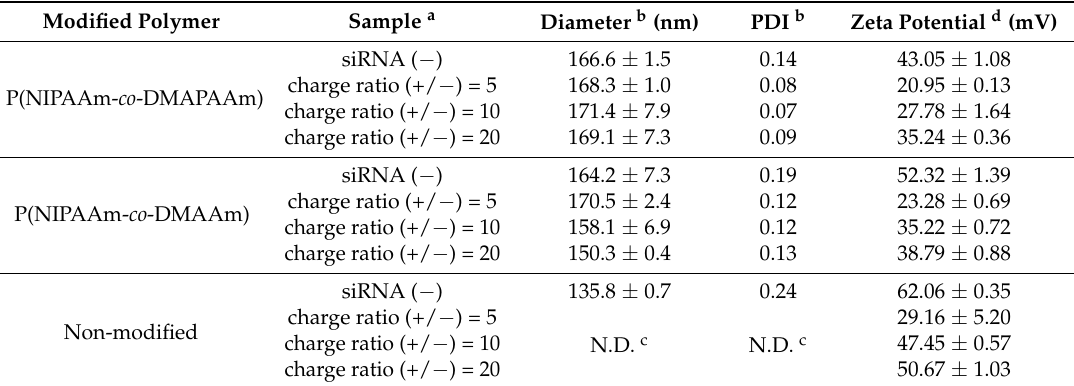
Table 2. Characterization of the prepared